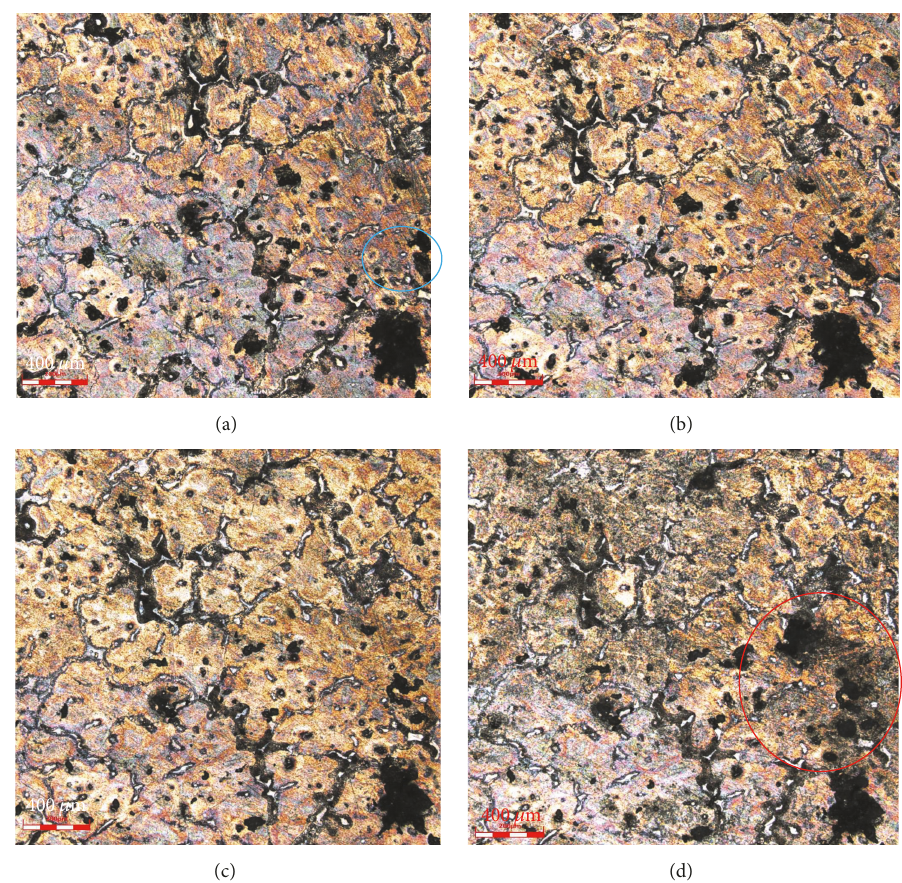
Figure 6: CLSM micrographs of the AZ91D alloy immersed for different times in 3.5 wt.% NaCl solution at room temperature: (a) as-received; (b) 1min; (c) 30 min; (d)